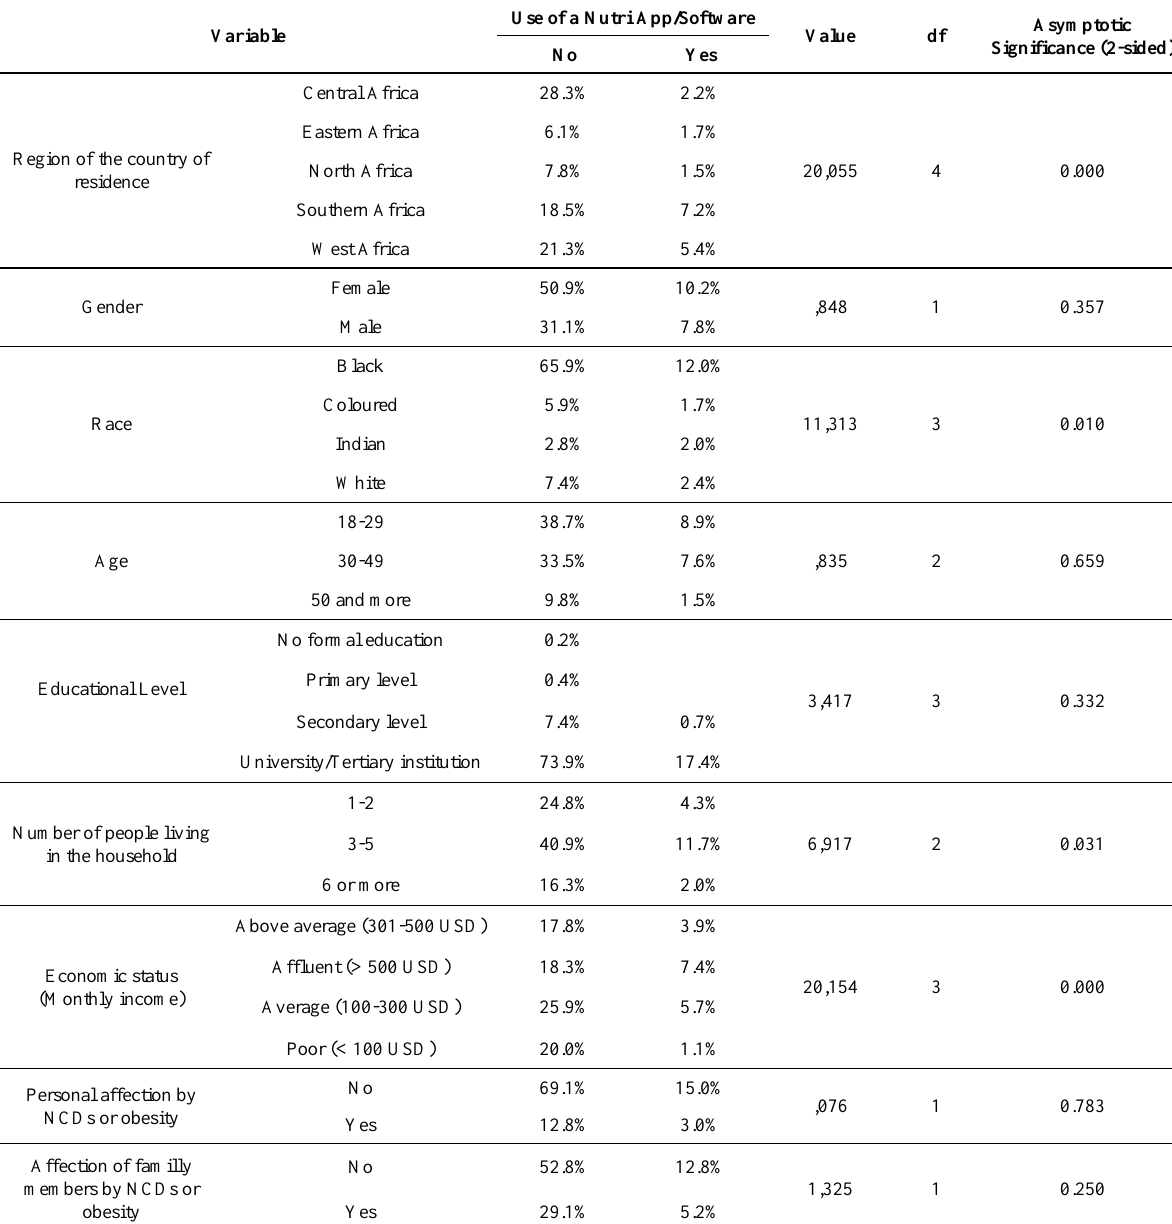
Table 3. Variation of the Nutri apps/software usage level with the sociodemographic variables of the population and their healthy status (N=460) Use of a Nutri App/Software Variable Value df